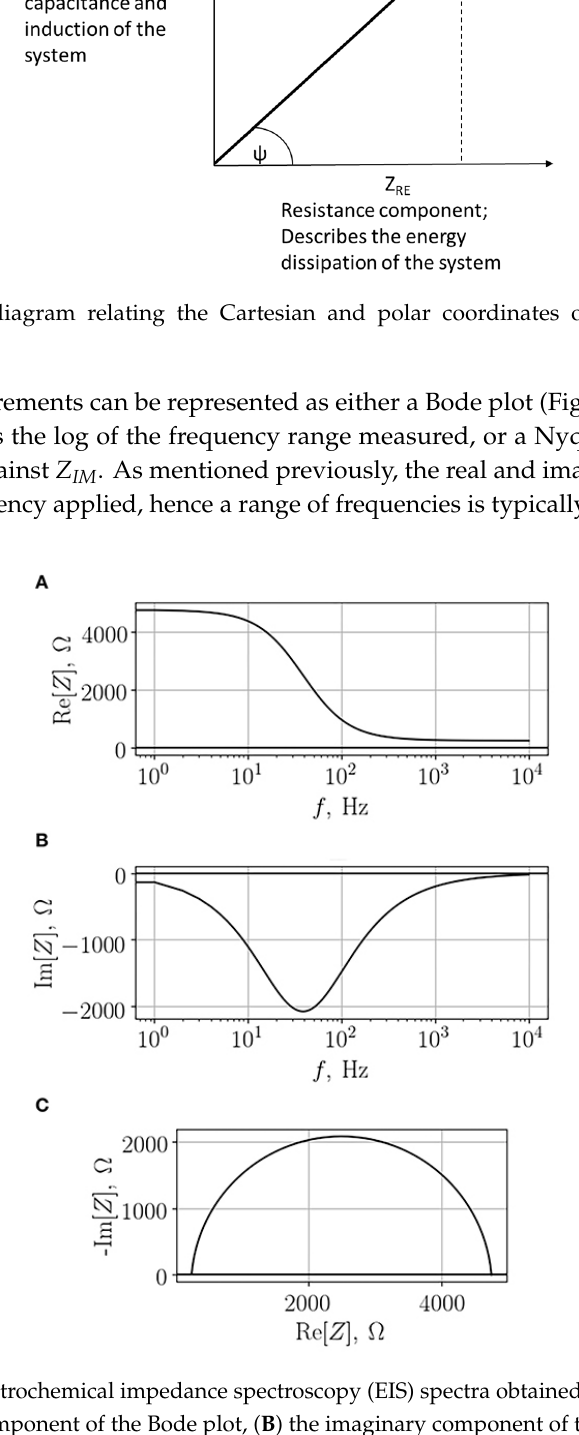
Figure 3. Phasor diagram relating the Cartesian and polar coordinates of impedance in the complex plane.